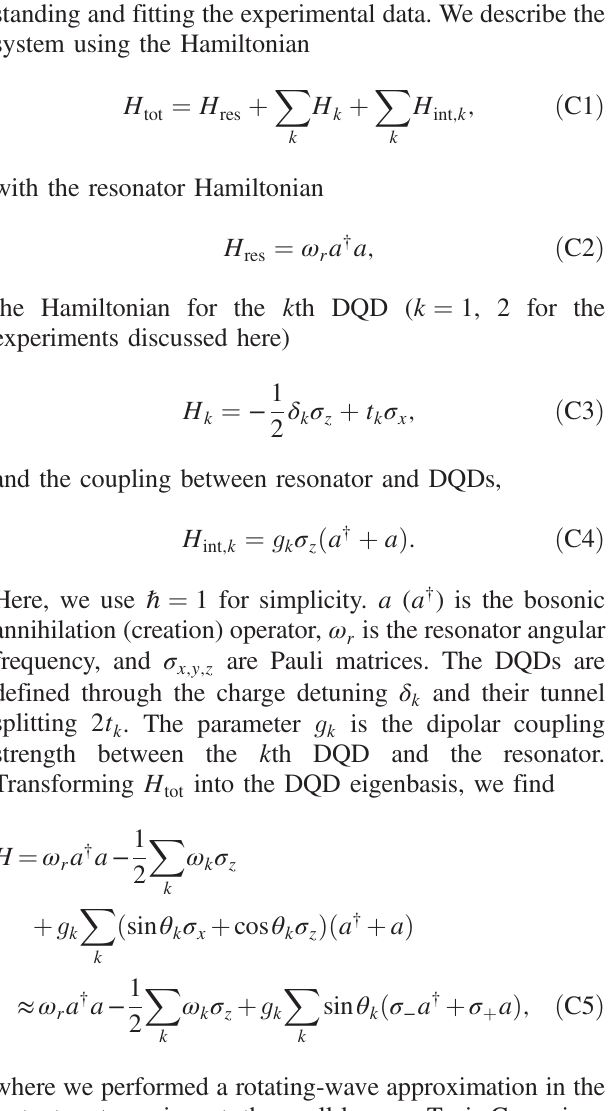
FIG. 6. Simplified schematic of the cryogenic and room- temperature components and equipment used in the experiments; further details are provided in the